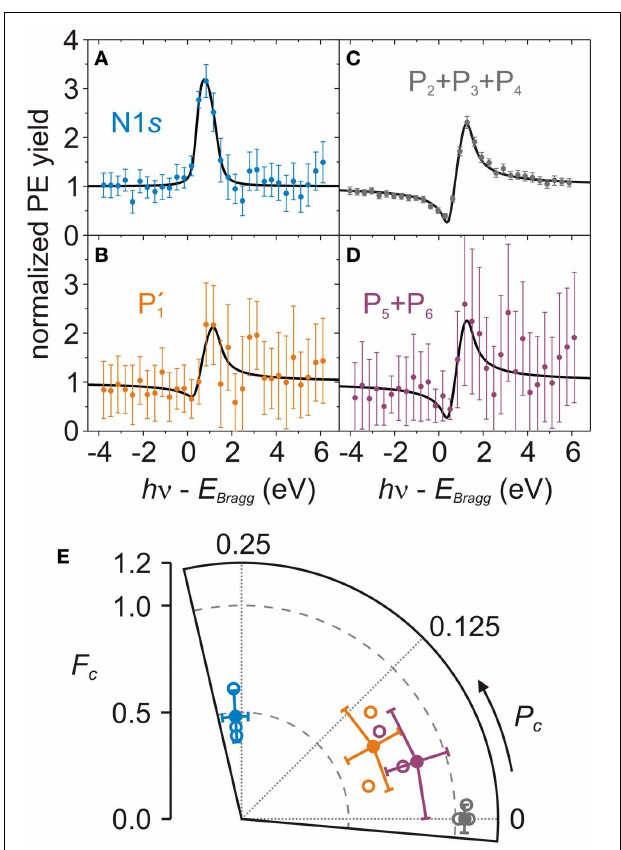
FIGURE 4 | Photoelectron yields and Argand diagram of N1 s core level and Ag3 d -plasmons. (A–D) Exemplary PE yield profiles (filled circles with error bars [4]) and fitting curves (black lines) of N1 s ( A , blue), P (cid:3) 1 ( B , orange), P 2 + P 3 + P 4 ( C , gray), P 5 + P 6 ( D , purple) measured on AB/Ag(111). Structure parameters: (A) P c = 0 . 26 ± 0 . 02, F c = 0 . 43 ± 0 . 07, χ 2 red = 1 . 03; (B) P c = 0 . 04 ± 0 . 04, F c = 0 . 61 ± 0 . 13, χ 2 red = 0 . 23; (C) P c = 0 . 00 ± 0 . 01, F c = 1 . 01 ± 0 . 02, χ 2 red = 0 . 53; (D) P c = 0 . 00 ± 0 . 02, F c = 1 . 02 ± 0 . 11, = 0 . 17. (E) Argand diagram of N1 s (blue open circles), P (cid:3) χ 2 1 (orange open red circles), P 2 + P 3 + P 4 (gray open circles), P 5 + P 6 (purple open circles) structure parameters ( P c , F c ) of the three NIXSW data sets and the corresponding averages (filled circles, Table 3 ). P (cid:3) 1 has two data points because the fit of the third PE yield did not converge [38]. The third P 5 + P 6 data point overlaps with the P 2 + P 3 + P 4 data point at F c = 1 . 01 [38].